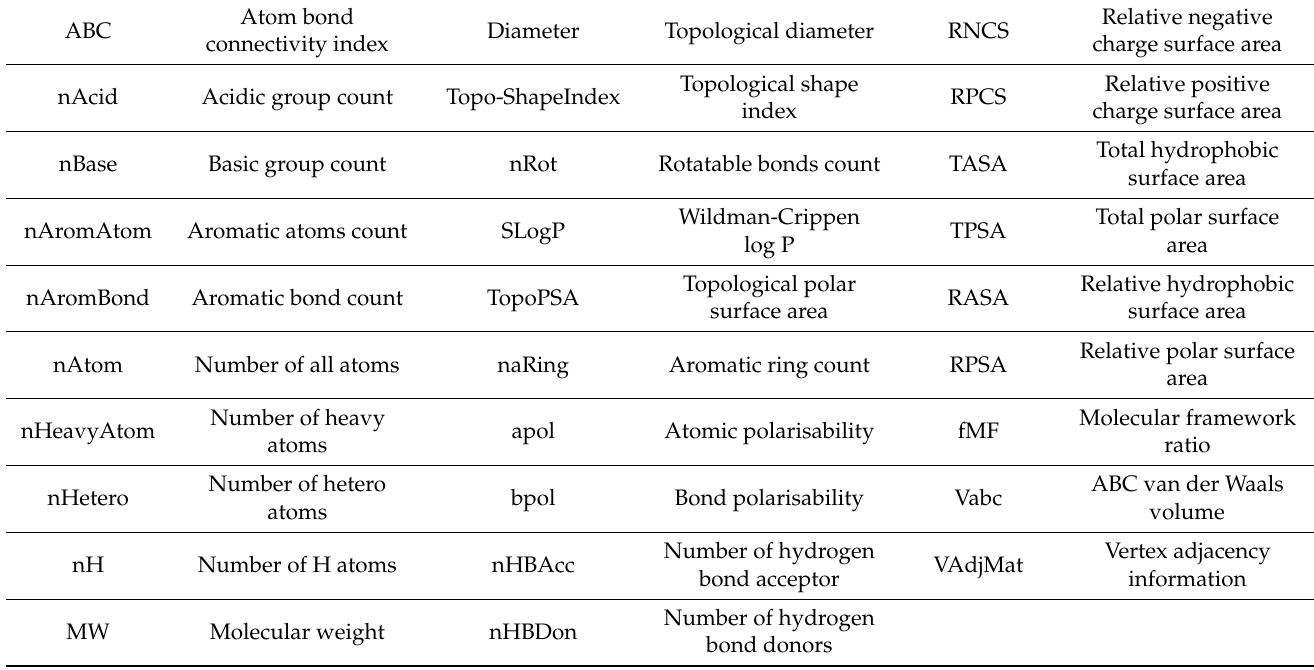
Table 1. Selected molecular descriptors and respective